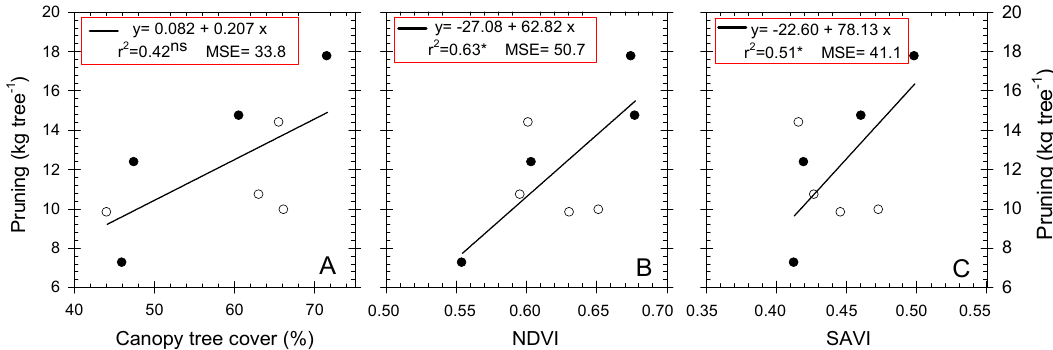
Figure 6. Relationship between the total pruning (kg tree − 1 ) and ( A ) canopy tree cover (%), ( B ) normalized difference vegetation index (NDVI), and ( C ) soil adjusted vegetation index (SAVI) in control ( ● ) and PDI (o) treatments during the 2017/2018 growing season 2017/2018. Each point corresponds to the selected trees. Values of NDVI and SAVI were obtained at t2 (12:00 GTM). ns, not-significant; * p ≤ 0.05, MSE mean square error.